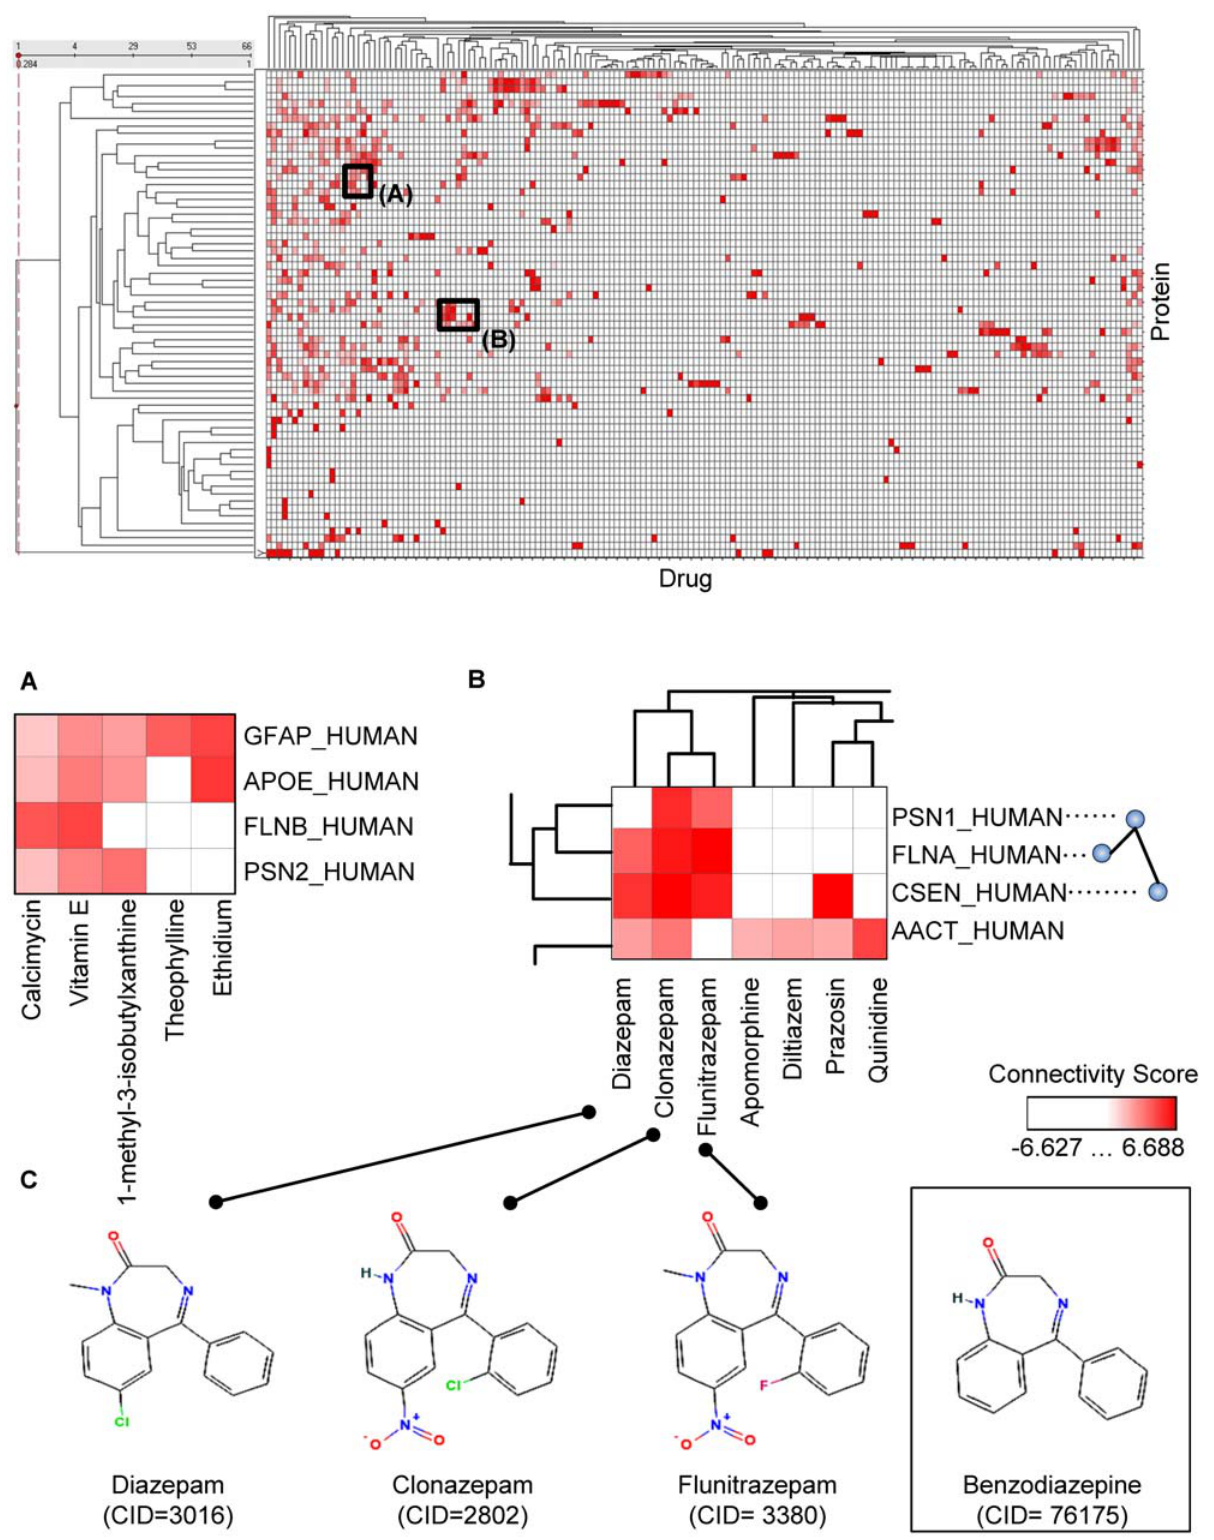
Figure 6. An AD connectivity map linking AD-related proteins to significant drugs. After ranking proteins involved in the AD related protein interaction network and selecting enriched drugs in AD network related corpus, 66 AD highly-relevant proteins and 166 significant AD candidate drugs are identified to construct an AD connectivity map. Hierarchical clustering of drugs and proteins are performed before results are shown as the final heatmap format, in which the x -dimension represents drugs and the y -dimension represents proteins. The color intensity for each cell is drawn in proportion to the connectivity score as shown in the heatmap legenda. Panels (A) and (B) show zoomed-in views of boxed regions A